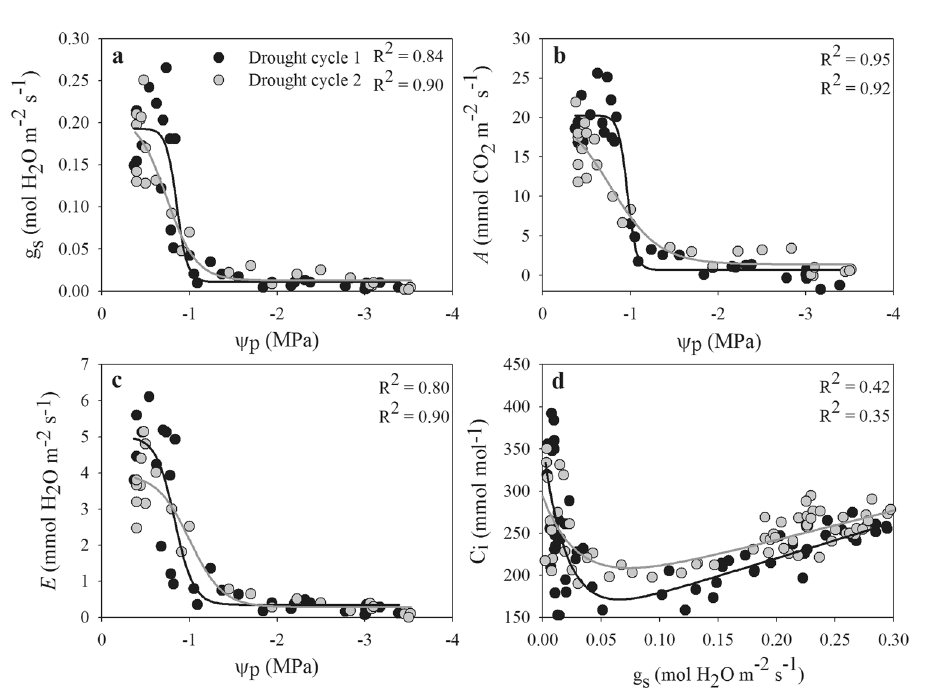
Figure 3. Relationships of measured g s , A and E with Ψ p and Ci with g s in R. pseudoacacia of drought plants during drought cycles 1 (black circles) and 2 (grey